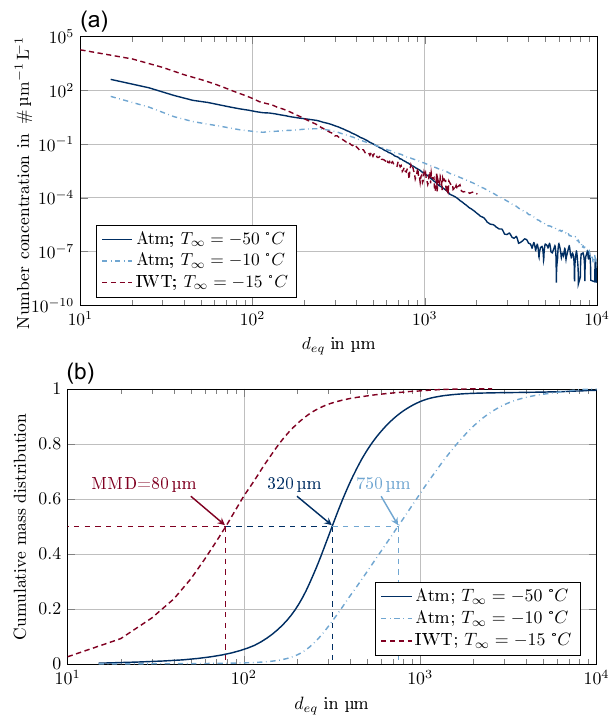
Figure 29. Comparison of artificial ice particle cloud to atmo- spheric cloud conditions: (a) particle size distribution and (b) cu- mulative particle size distribution.